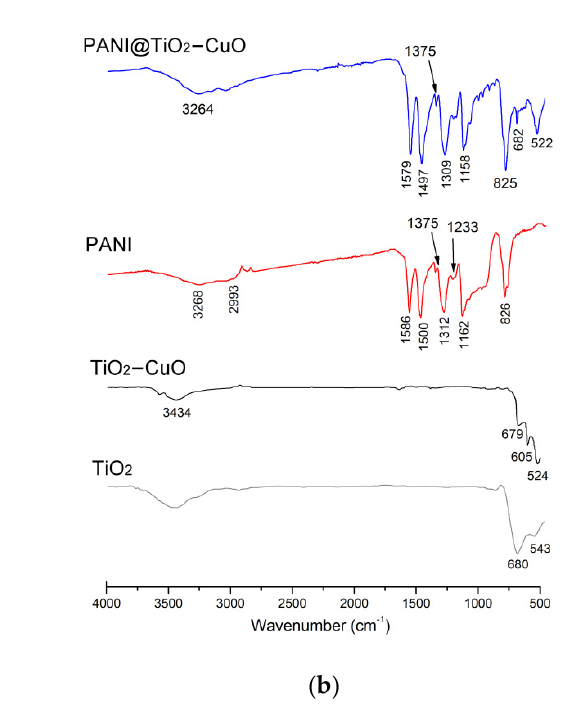
Figure 2. ( a ): Survey XPS spectra and ( b ): N 2 sorption isotherms of samples. Furthermore, as can be seen in Figure 3a, the high spectral resolution of the C1s peak for PANI showed three sub-peaks at 284.26 eV, 285.66 eV and 286.09 eV, which were as- signed to the C–C/C–H, C–N and C=N bonds, respectively. The high-resolution spectra of ternary composite for N1s (Figure 3b) displayed two sub-peaks at 398.97 eV and 400.28 eV related to –N= and –NH–, respectively [29,30]. However, after the loading of polymer matrix onto the surface of TiO 2 –CuO, the C1s peak of PANI@TiO 2 –CuO showed a